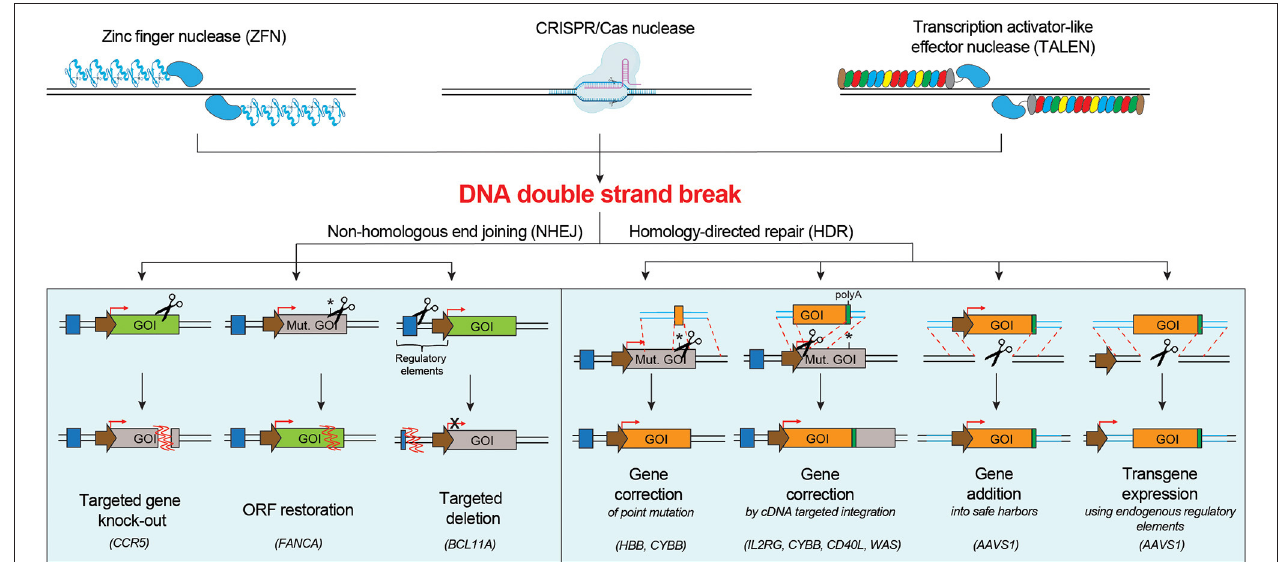
FIGURE 1 | Schematic of the main DNA double strand break repair mechanisms in human cells and their possible applications for targeted genome editing. NHEJ pathway engagement may be exploited for knocking-out a gene, correcting a gene by restoring its open reading frame (ORF), inserting a targeted deletion. HDR pathway engagement may be exploited for gene correction of point or multiple mutations, gene addition in a safe harbor locus or targeted transgene expression using endogenous regulatory elements. Mut. GOI, Mutated Gene Of